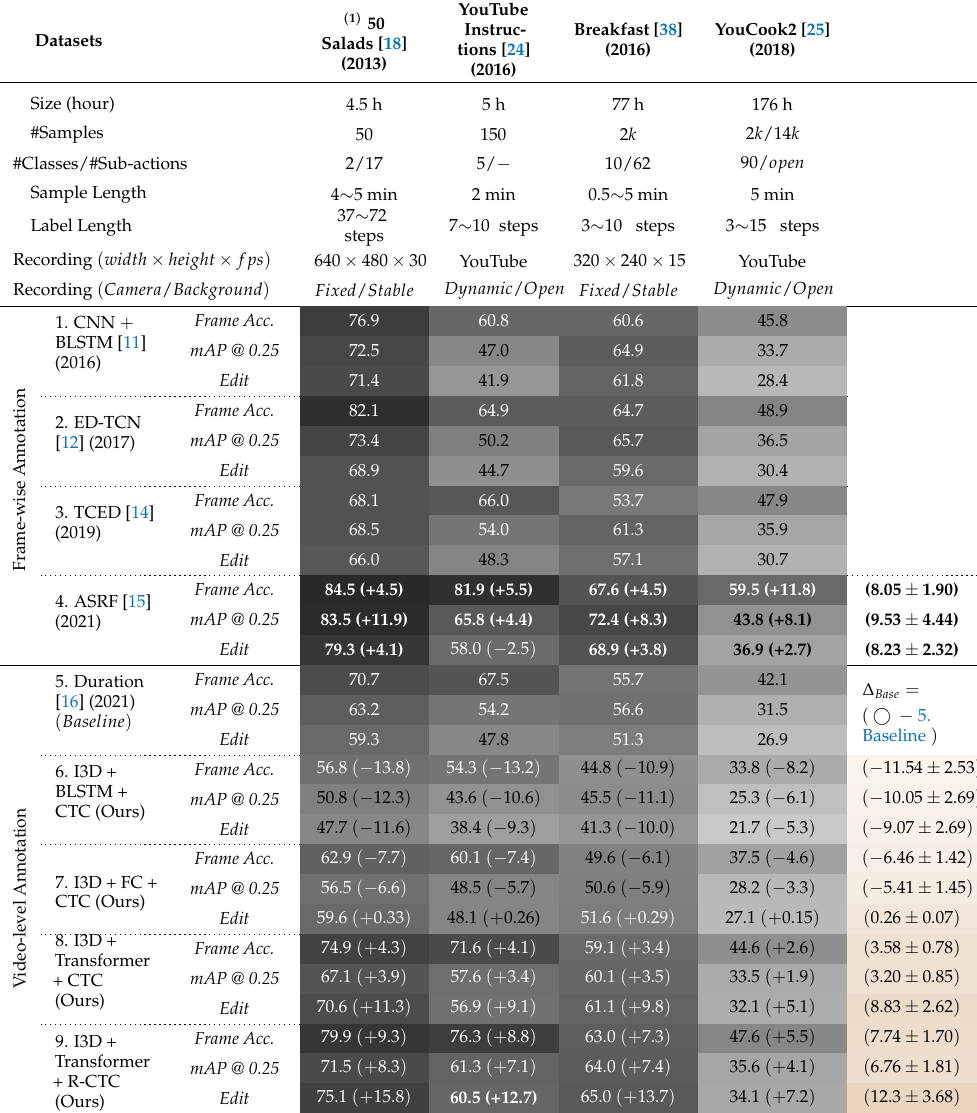
Table 4. Accuracy across different datasets (%). All referenced baselines under both training conditions (Row 1 ∼ 4) are re-implemented under the same empirical control (i.e., identical datasets and evaluation metrics) to facilitate consistent comparisons against our proposed variants (cid:63) . Results are means over 4 runs (variances are omitted for readability). All differences are significant ( p < 0.01 ) . The bold-faced font highlights the best results obtained on the given data set. The values in brackets calculate the absolute increments of the current row (denoted by (cid:13) ) relative to the row referenced in the rightmost column. The second to the rightmost column calculates the statistical means and variances of the corresponding increments across different datasets within the same